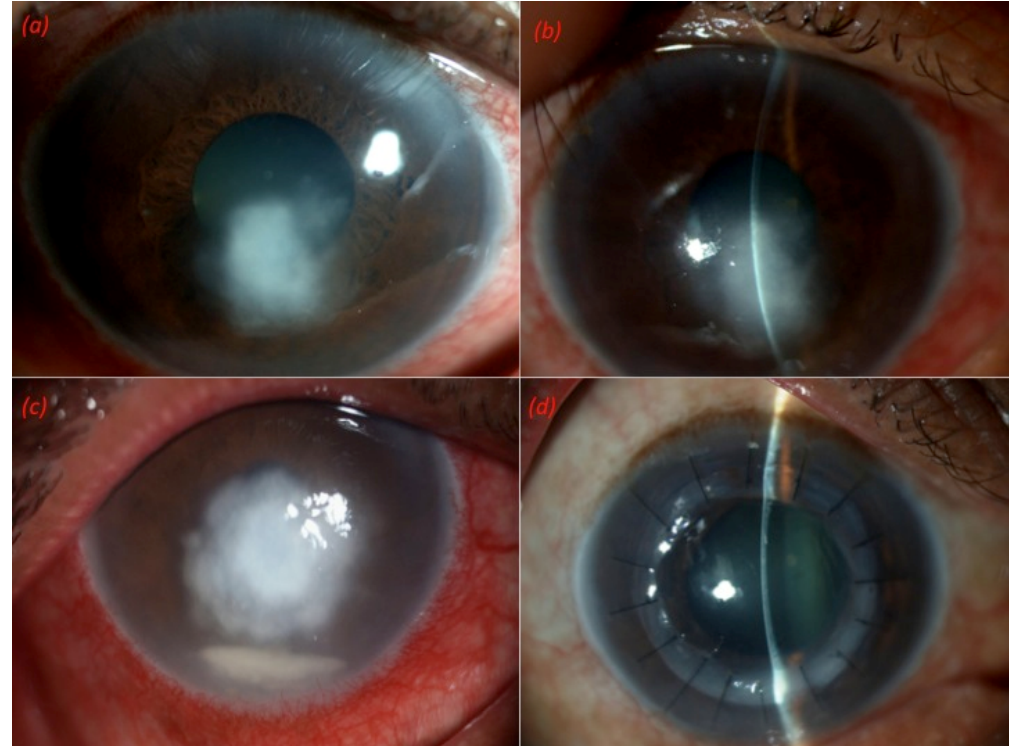
Figure 2: (a) Right eye showing mid stromal greyish infiltrate measuring 4 mm x 3 mm with intact overlying epithelium. (b) Third day picture with increase in the size of the infiltrate. (c) One week picture showing appearance of hypopyon along with the preexisting infiltrate. (d) Six months postoperative picture showing clear graft.